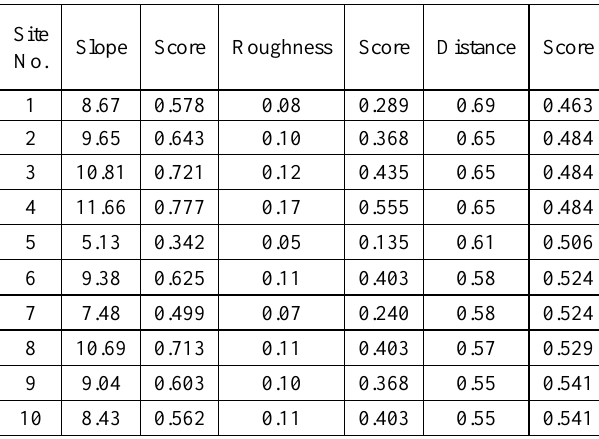
Table 1. Each site’s sub-index value and its corresponding score The calculation for safe landing site selection occupied most of the time of the whole process. The reason is that removing redundant voronoi edge and searching candidate sites could consume too much computing resources. Actually, removing additional edges only promoted visual effect, but had no help on site selection. So in practical applications, we will not do